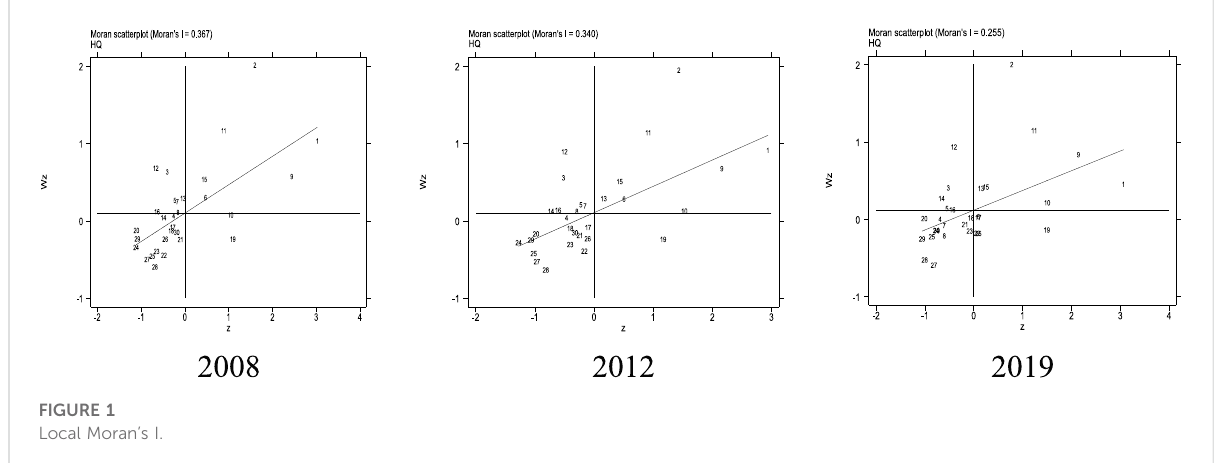
FIGURE 1 Local Moran ’ s